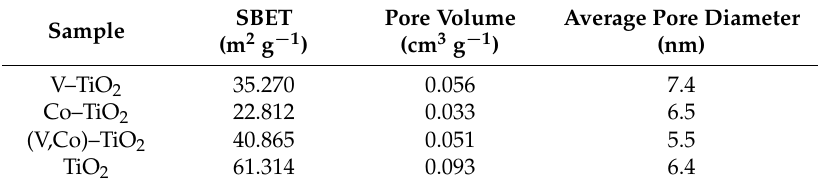
Figure 4. Nitrogen adsorption–desorption isotherm ( a ) and the corresponding pore size distribution ( b ) for TiO 2 , V–TiO 2 , Co–TiO 2 , and (V,Co)–TiO 2 samples. Table 2. S BET , pore volume, and average pore size of TiO 2 , V–TiO 2 , Co–TiO 2 , and (V,Co)–TiO 2